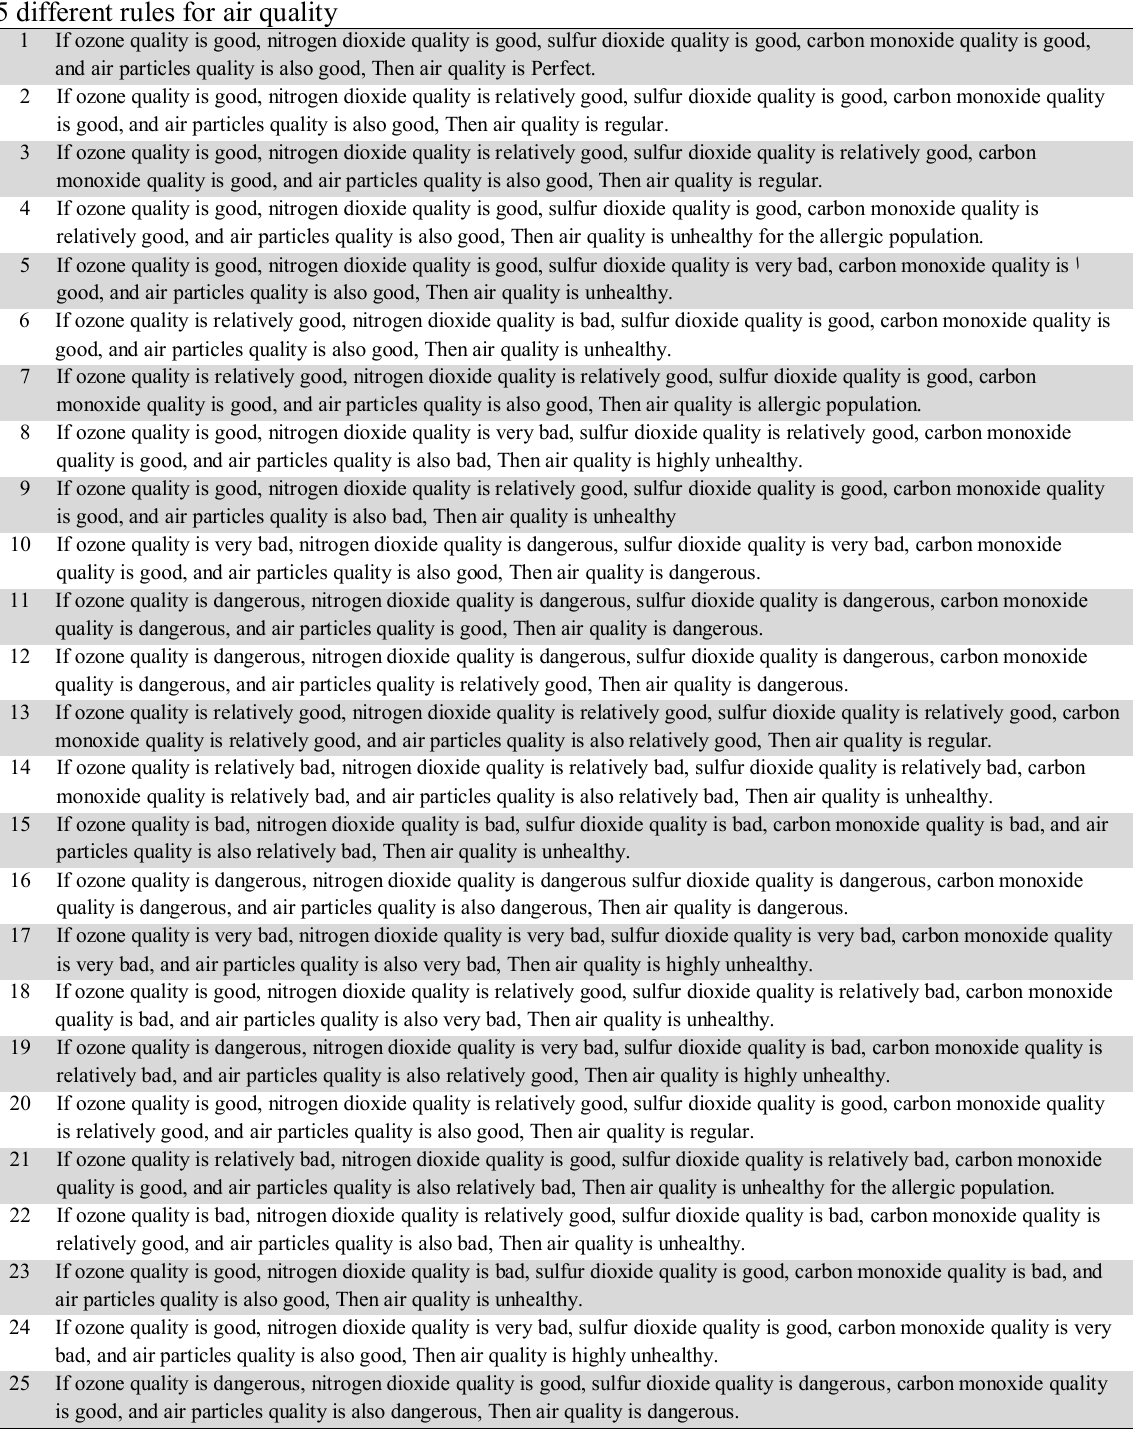
25 different rules for air